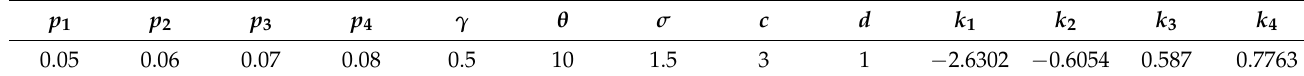
Table 1. Initial system’s state conditions and system coefficients.